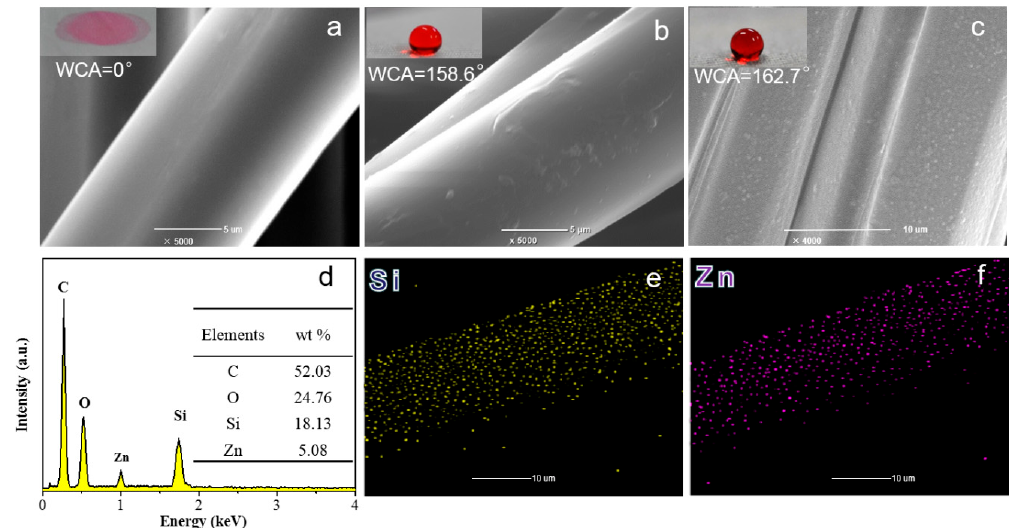
Figure 1. Surface texture and surface chemistry element analysis. SEM images: ( a ) the pristine farbic, ( b ) polyester-polydimethylsiloxane (PET-PDMS) fabric, ( c ) PET-PDMS@ZnO fabric; ( d ) EDX spectrum of the PET-PDMS@ZnO fabric; elemental mapping of silicon ( e ) and zinc ( f ) for the PET-PDMS@ZnO fabric.